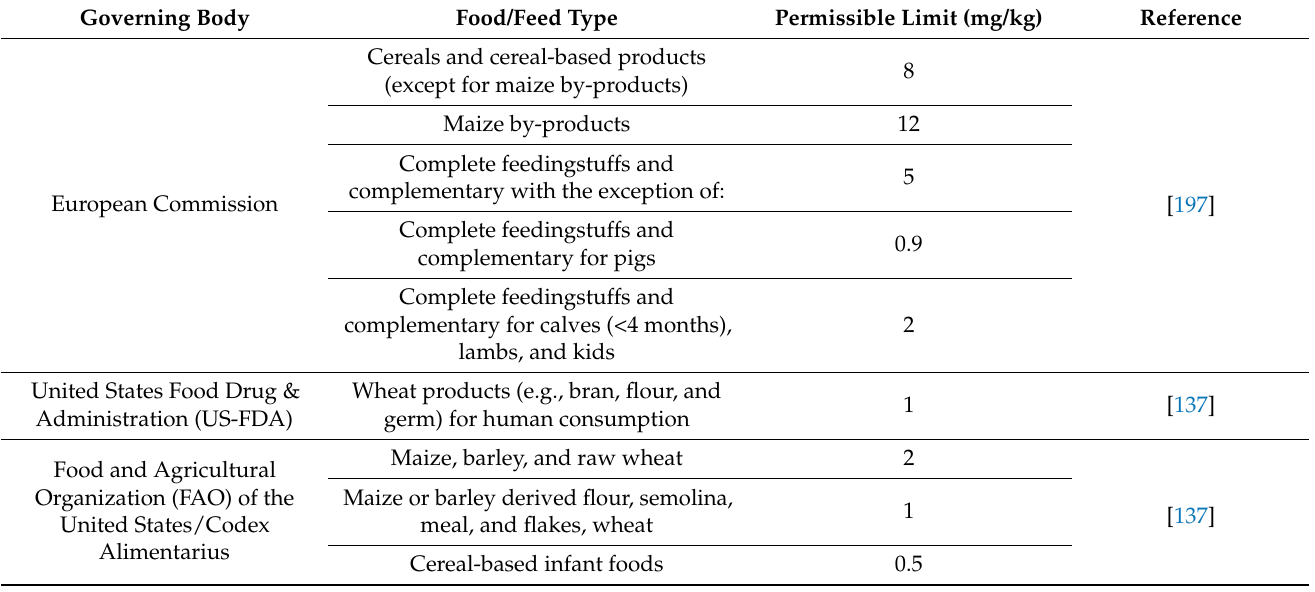
Table 2. Permissible limits of DON in various foods and feeds established by different govern- ing